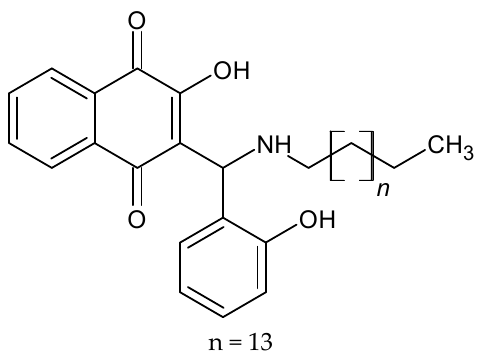
Figure 8. The structure of the new active derivative of naphthoquinone.